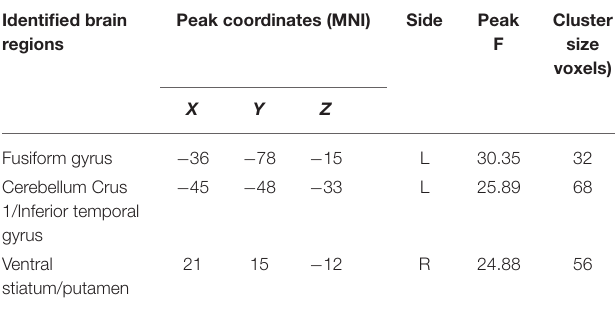
TABLE 3 | Brain regions showing significant smoking-by-sex interaction on regional homogeneity (ReHo) (voxel-level p < 0.05 corrected for false discovery rate).